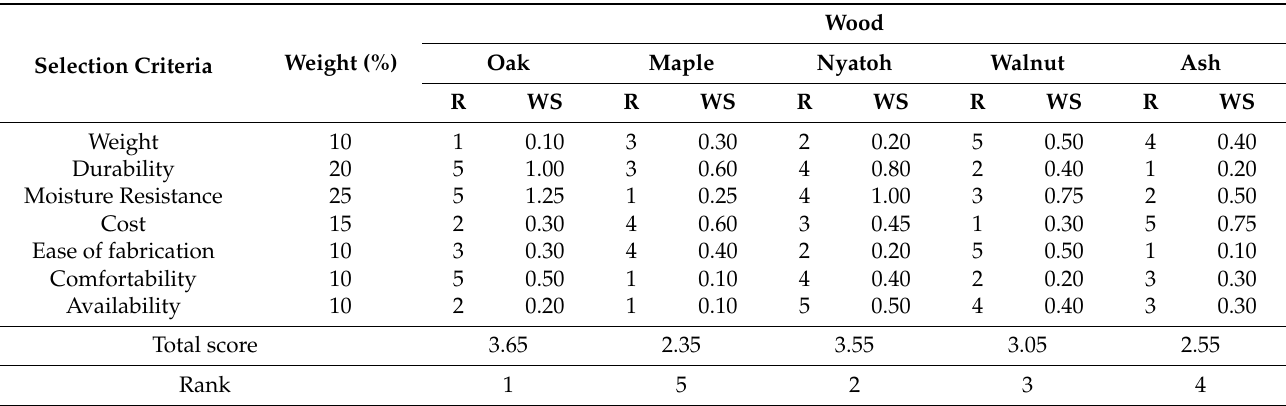
Table 8. Scoring of